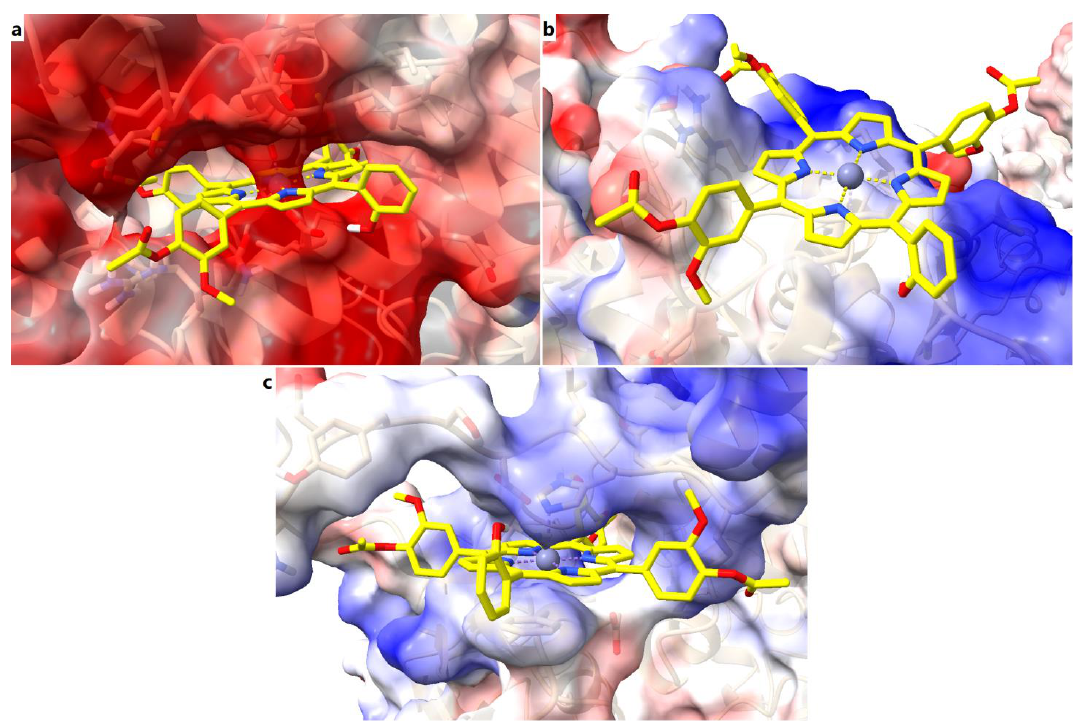
Figure 10. Electrostatic potential maps of the binding sites in complex with Zn(II)TMAPOHo. ( a ) – binding site of SERCA2b; ( b ) – binding site of Slo1; ( c ) – binding site of SUR2.